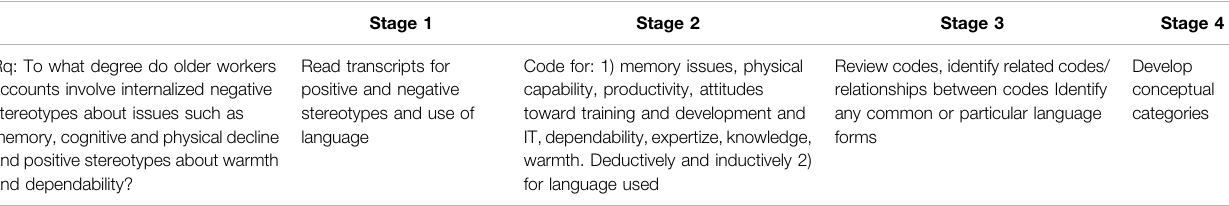
TABLE 2 | Framework for qualitative